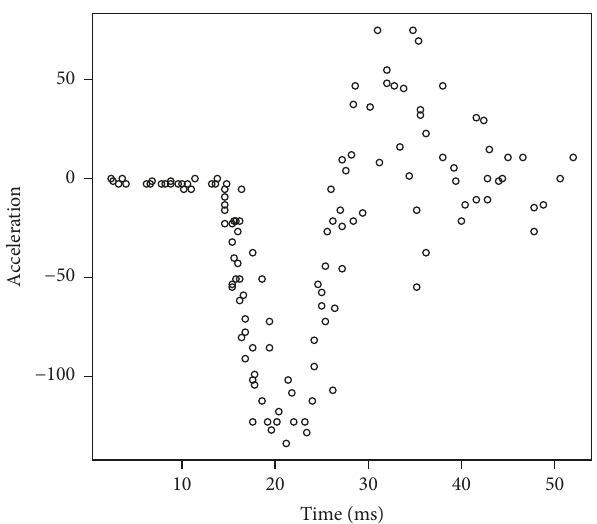
Figure 10: Plots the motorcycle crash data introduced by [27].